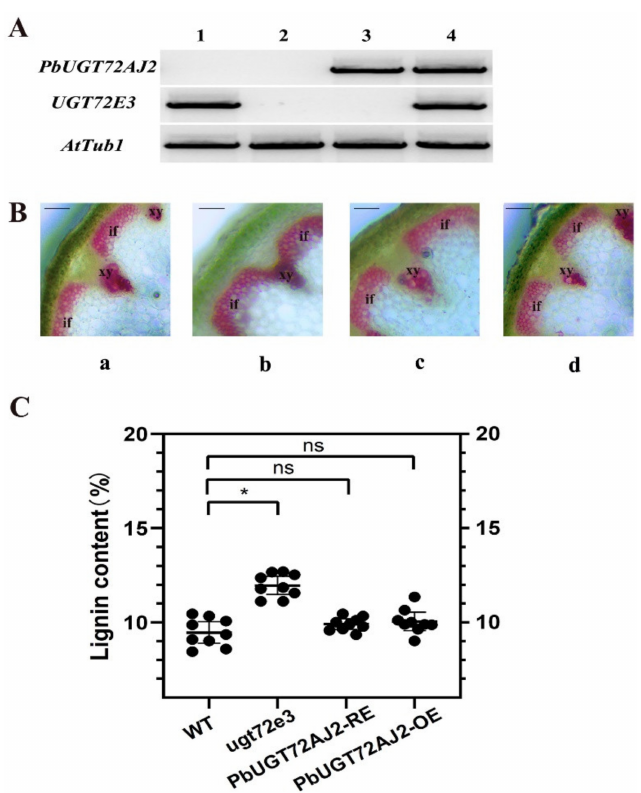
Figure 5. The lignin content in inflorescence stems of Arabidopsis thaliana . ( A ) RT-PCR analysis of Arabidopsis thaliana wild type (1), UGT72E3 mutant (2), UGT72E3 mutant lines rescued by PbUGT72AJ2 (3) and PbUGT72AJ2 overexpressing Arabidopsis thaliana (4). ( B ) cross-sections of the inflorescence stem were stained with phloroglucinol–HCl (lignin appears red when dyed); (a) Wild-type (WT) plants; (b) UGT72E3 knockout mutant plants; (c) PbUGT72AJ2 rescue plants; (d) over-expression PbUGT72AJ2 plants. The bar = 100 µ m; xy, xylem tracheary elements; if, interfascicular fiber cells. ( C ) Measurement of the lignin content in inflorescence stems of Arabidopsis thaliana . The asterisks indicate significant differences compared to the wild-type plants (* p < 0.05; ns, no significance).